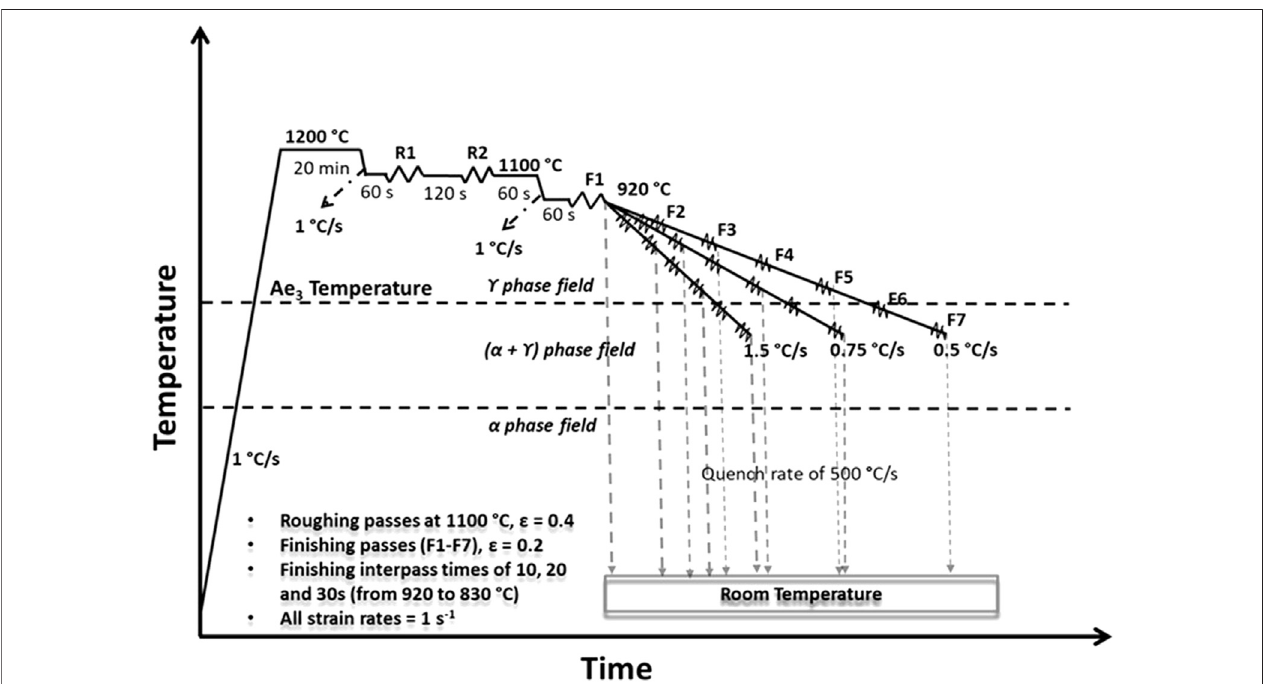
FIGURE 1 | The thermomechanical schedule of the present physical simulation employing continuous cooling scenario.